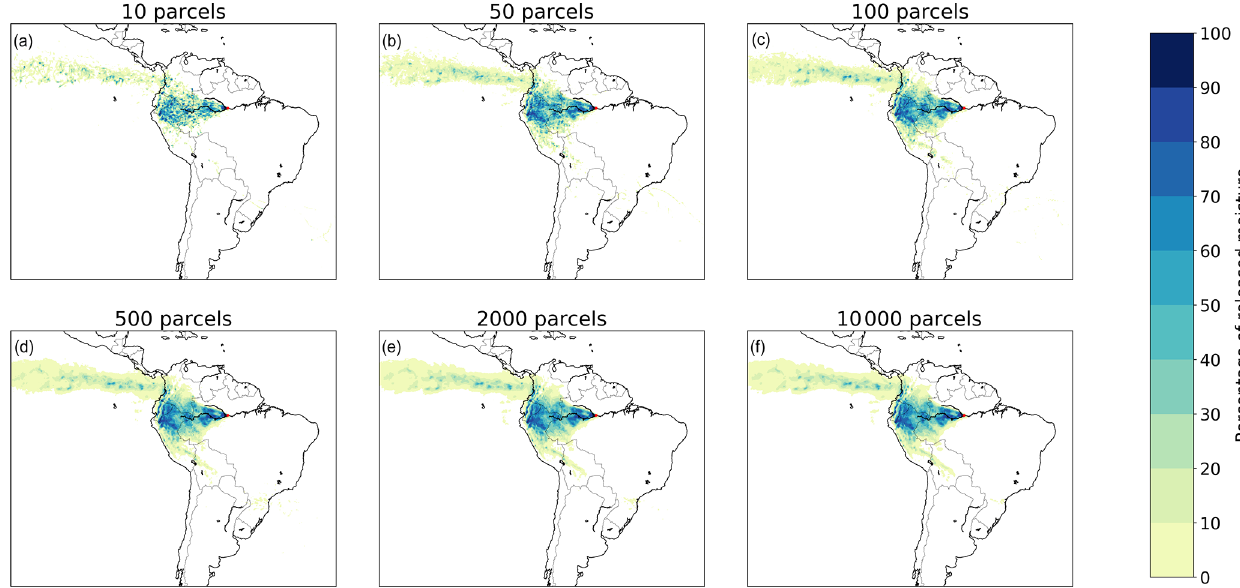
Figure 4. Different footprints of moisture releases from Manaus in July 2012 in a three-dimensional Lagrangian model with 10, 50, 100, 500, 2000, and 10000 tracked parcels per millimetre. (a) 10 parcels, with a mean latitudinal moisture flow of 1.3 ◦ in a northerly direction and mean longitudinal flow of 14.2 ◦ in a westerly direction; (b) 50 parcels, with a mean latitudinal moisture flow of 1.6 ◦ in a northerly direction and mean longitudinal flow of 14.3 ◦ in a westerly direction; (c) 100 parcels, with a mean latitudinal moisture flow of 1.4 ◦ in a northerly direction and mean longitudinal flow of 14.2 ◦ in a westerly direction; (d) 500 parcels, with a mean latitudinal moisture flow of 1.4 ◦ in a northerly direction and mean longitudinal flow of 14.3 ◦ in a westerly direction; (e) 2000 parcels, with a mean latitudinal moisture flow of 1.5 ◦ in a northerly direction and mean longitudinal flow of 14.4 ◦ in a westerly direction; (f) 10000 parcels, with a mean latitudinal moisture flow of 1.5 ◦ in a northerly direction and mean longitudinal flow of 14.3 ◦ in a westerly direction.